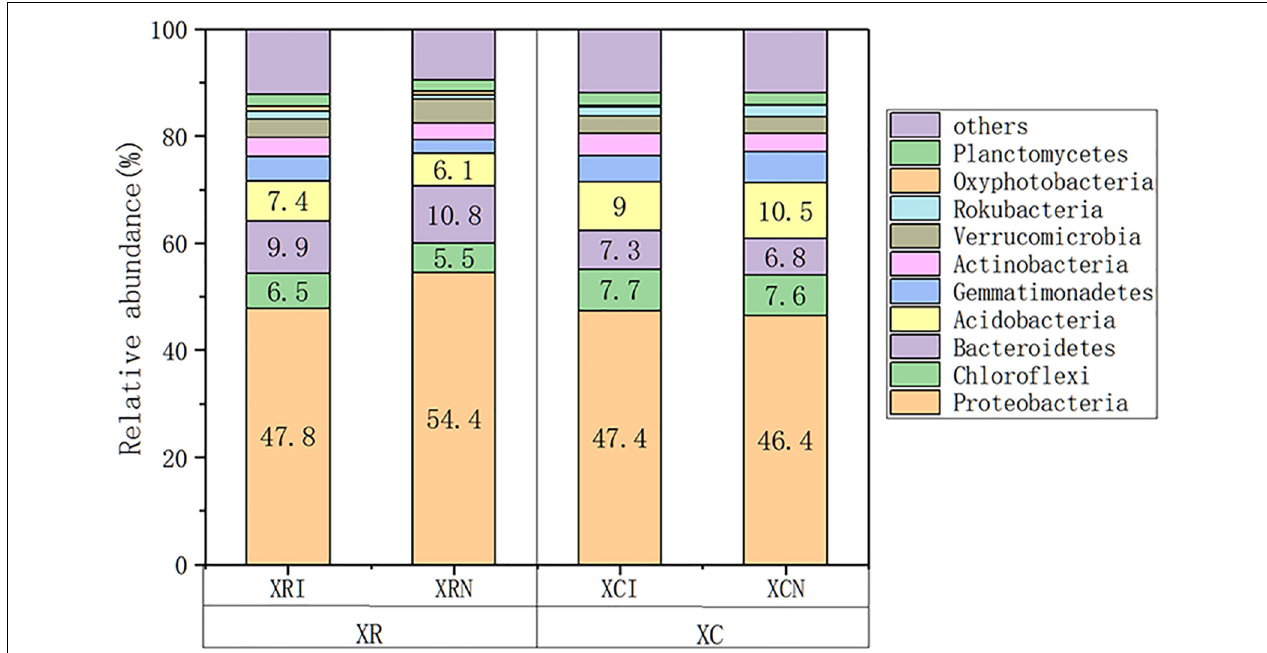
FIGURE 4 | Relative abundance of soil microbial species at invaded sites and non-invaded sites in the two types of wetlands. XRI, Xinxue River invaded sites; XRN, Xinxue River non-invaded sites; XCI, Xinxue River Constructed Wetland invaded sites; XCN, Xinxue River Constructed Wetland non-invaded sites. TABLE 2 | Alpha Diversity analysis index of invaded sites and non-invaded sites of two types of wetlands. Invasion Observed species Shannon Simpson chao1 ACE OTU XR XRI 6,712